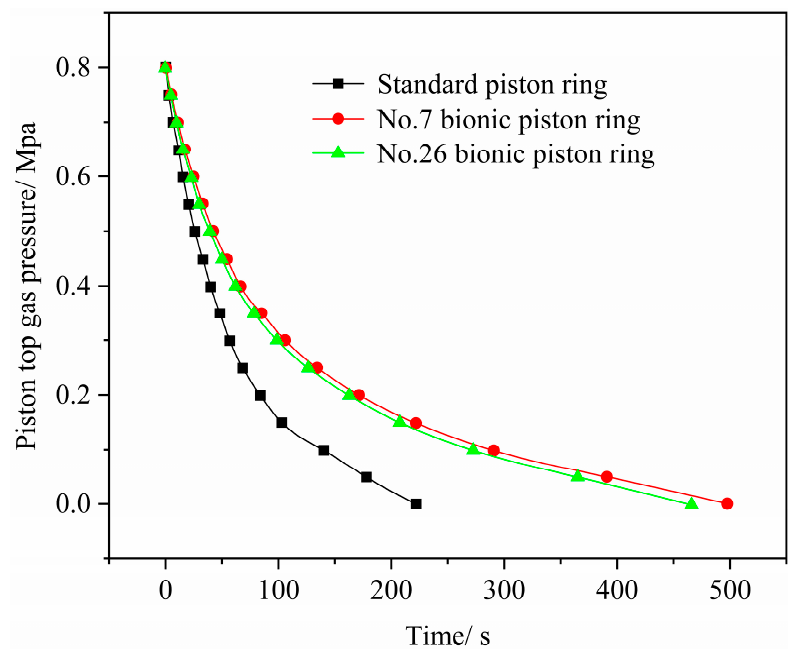
Figure 10. Change curve of gas pressure in the engine piston’s top chamber.